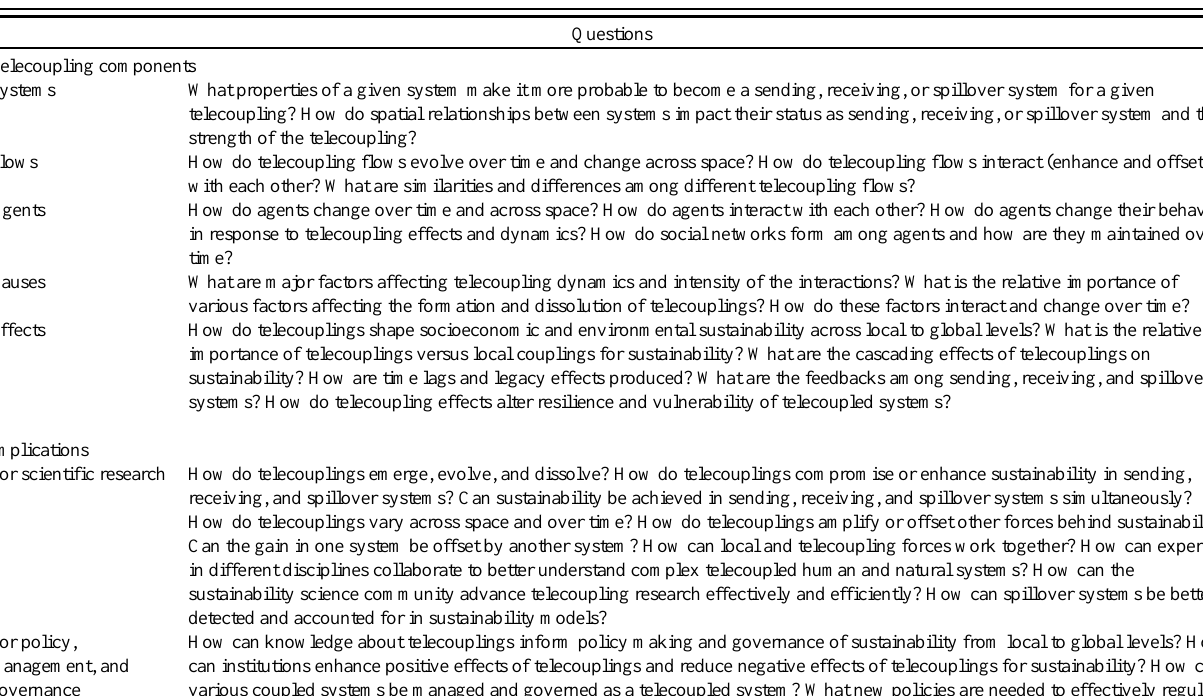
Table 3 . Example questions for further research on telecouplings and